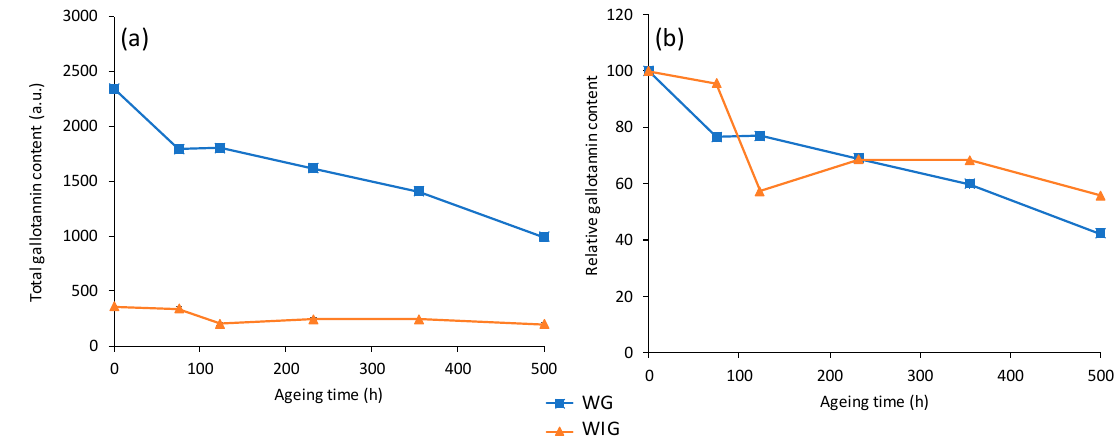
Figure 3. ( a ) Total gallotannins content of samples dyed with oak gallnuts using no mordant (WG) and iron mordant (WIG) as a function of ageing time; ( b ) gallotannins content relative to the nonaged samples as a function of ageing time.